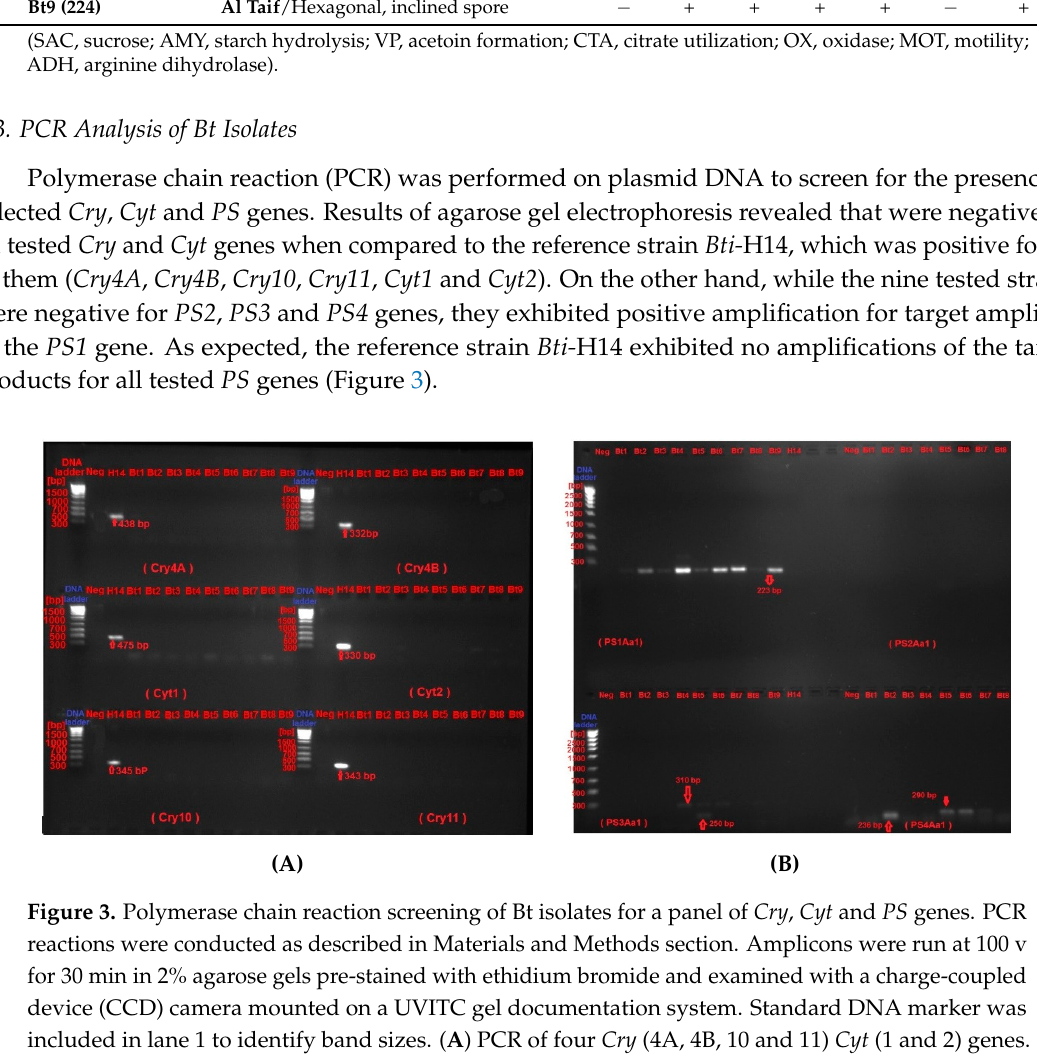
Table 1. Biochemical typing of Bt isolates.